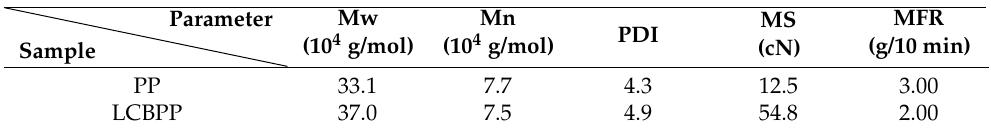
Table 2. Basic parameters of PP and